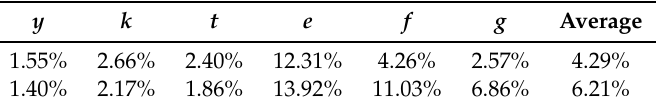
Table 16. Percentage difference from origal